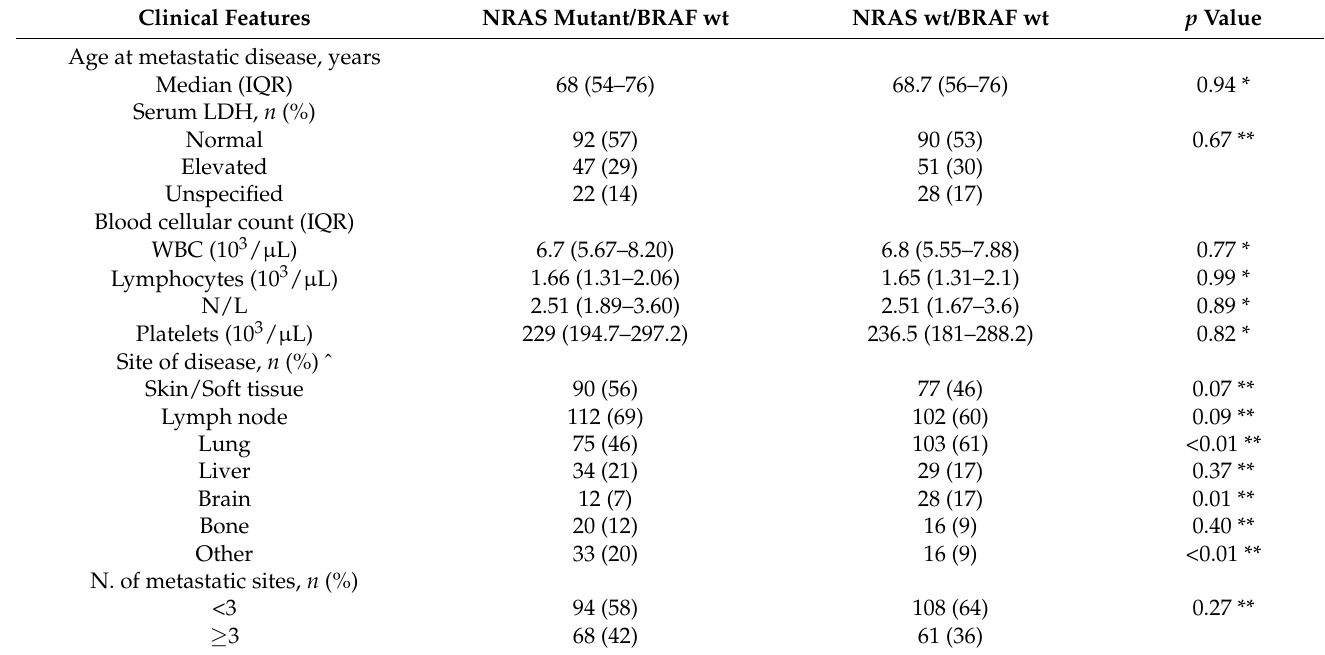
Table 3. Patient and disease characteristics of the two cohorts at metastatic